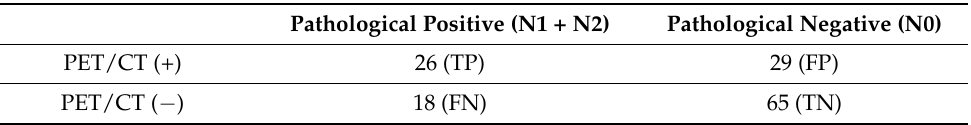
Table 3. Histological findings and integrated 18F-FDG-PET/CT results of HMLN. TP: true positive, FN: false negative, FP: false positive, TN: true negative.